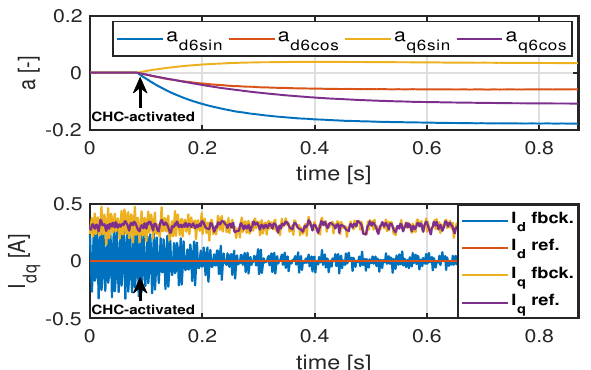
Figure 15. Transient state of amplitude coefficients and dq currents after turning on CHC.